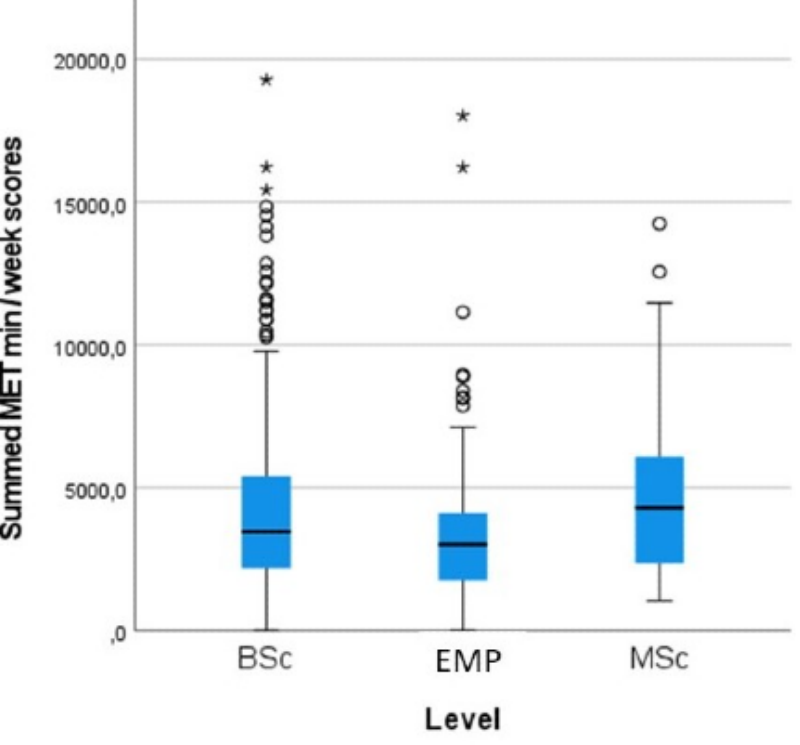
Figure 2. Box plots of the physical activity scores (summed metabolic equivalent [MET] min/week scores) for students and employees (n=650) of a Swiss university of applied sciences (health professions) during the spring 2020 COVID-19 lockdown. Whiskers indicate 1.5 × IQR unless truncated at the lowest score. Asterisks and circles represent values outside this range. BSc: Bachelor of Science students; EMP: employees; MSc: Master of Science